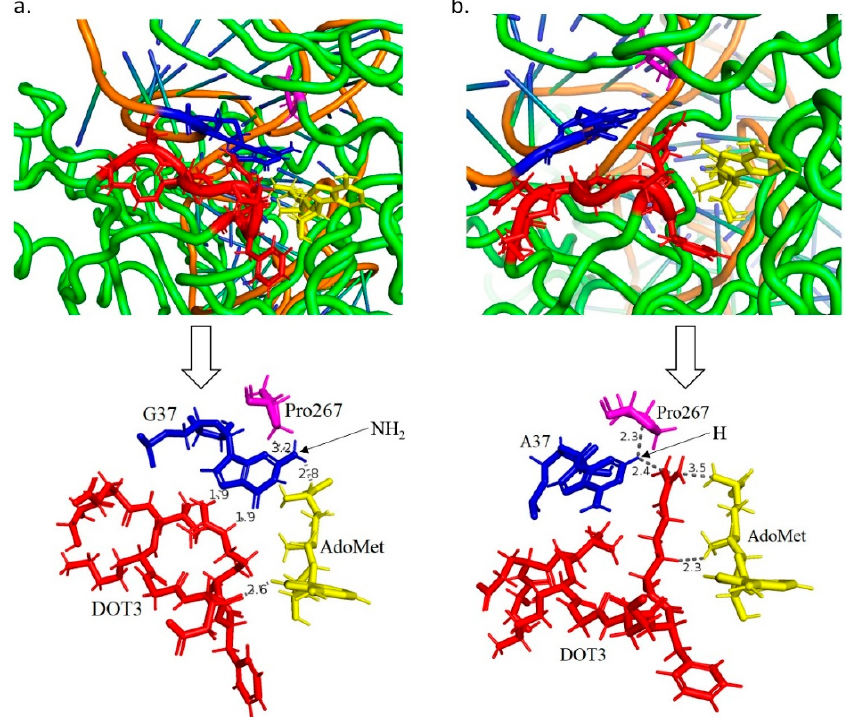
Figure 5. Interaction of DOT3 (red), G37 (blue), AdoMet ligand (yellow), and Pro267 (purple) in ( a ) wild-type and ( b ) G37A complex. The top figures show the positions of DOT3, G37, Pro267, and AdoMet ligand in the overall complex, while the bottom figures only show these regions for better visualisation and interactions analysis. The distance of AdoMet ligand with DOT3, G37, and Pro267 is less than 4 Å. All the distances are in Å.